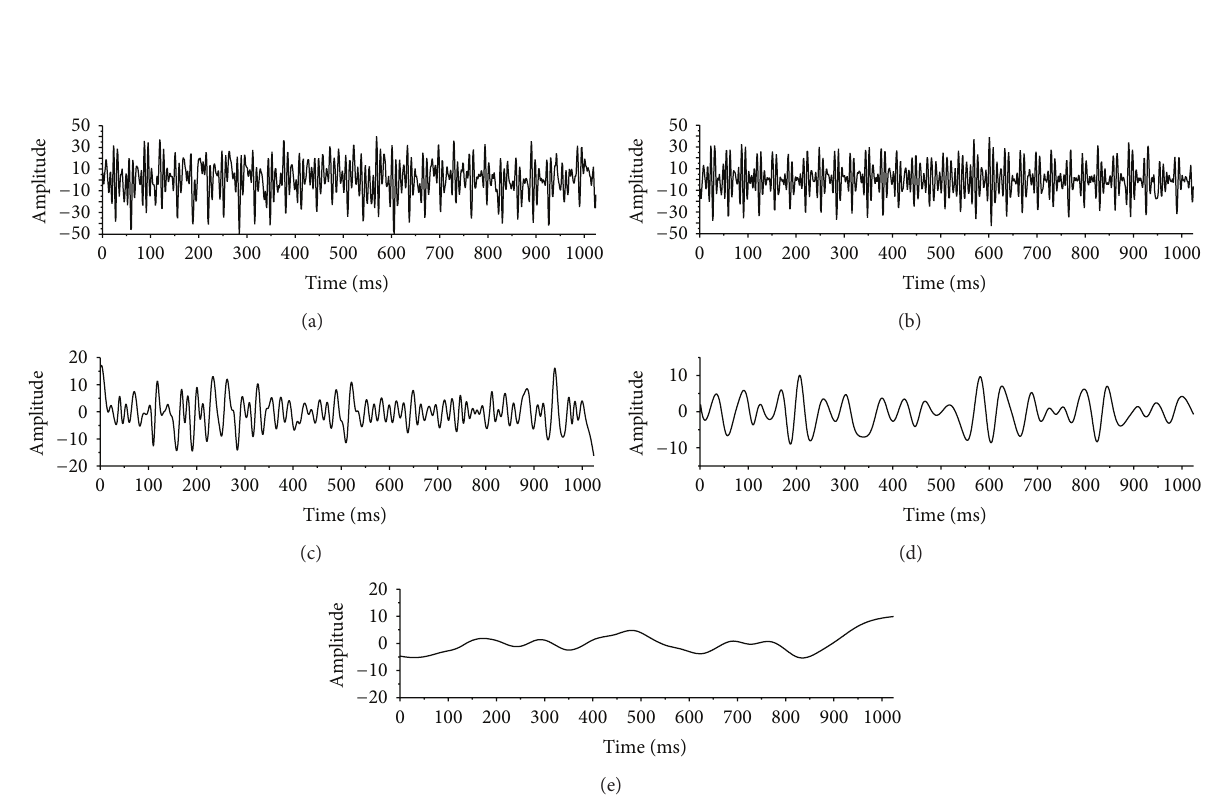
Figure 17: Inner ring fault signal and